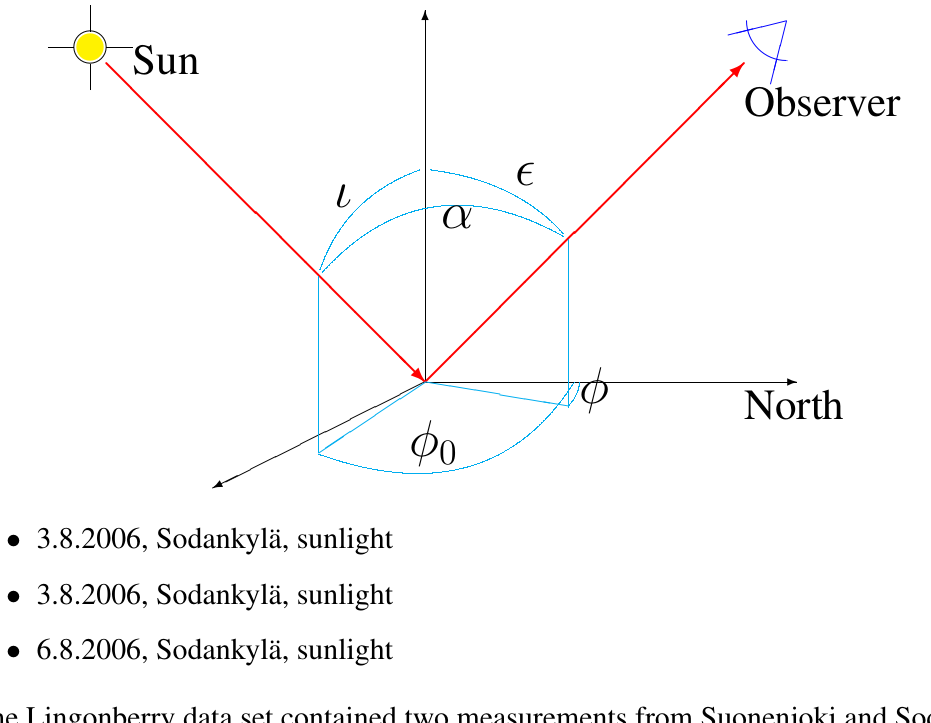
Figure 2. Definition of the angles used in surface reflectance work: ϵ and ι are the zenith angles of the emergent (Observer) and incident (solar) radiation respectively, ϕ and ϕ the corresponding azimuths. The phase or back scattering angle α is the angle between the Observer and the Sun. The principal plane is fixed by the solar direction and the surface normal to it, while the cross plane is a vertical plane perpendicular to the principal